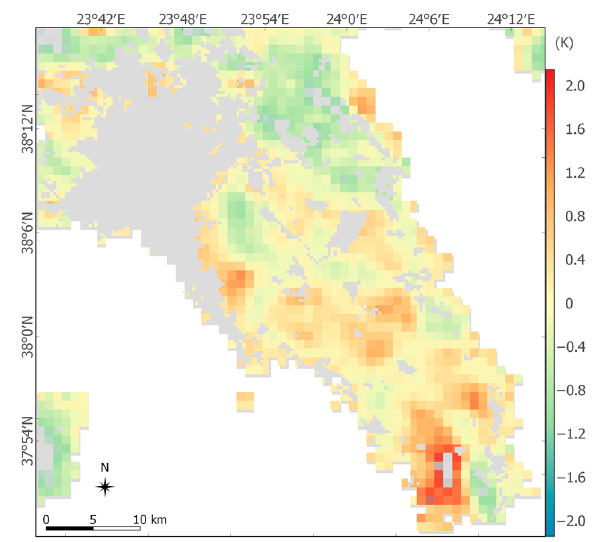
Figure 9. LST trend values (in °K) of the non-urban pixels of Athens (Daytime).